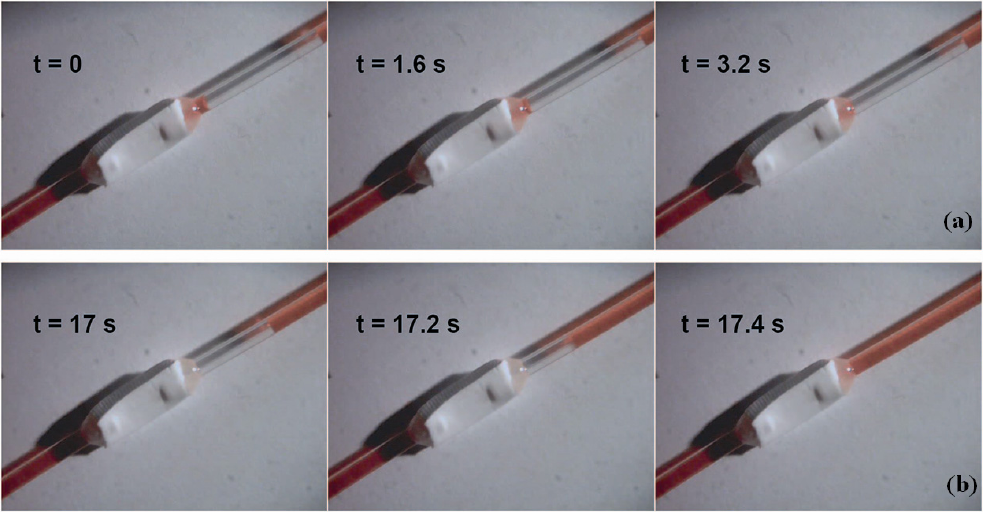
Figure 4. Sequence of bubble removal with inline demonstration debubbler, with colored water inside a 1 mm inner diameter tube. ( a ) 8 µL air bubble approaching debubbler, flow rate ca . 0.2 µL/s; ( b ) air expulsion through debubbler membrane, observed flow rate up to ca . 25 µL/s.